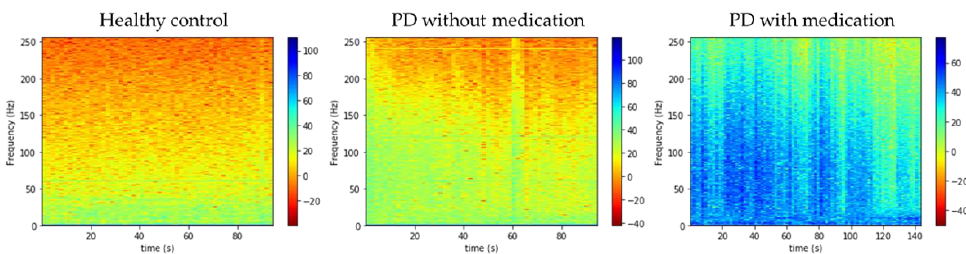
Figure 4. Spectrograms of three respective groups of subjects.